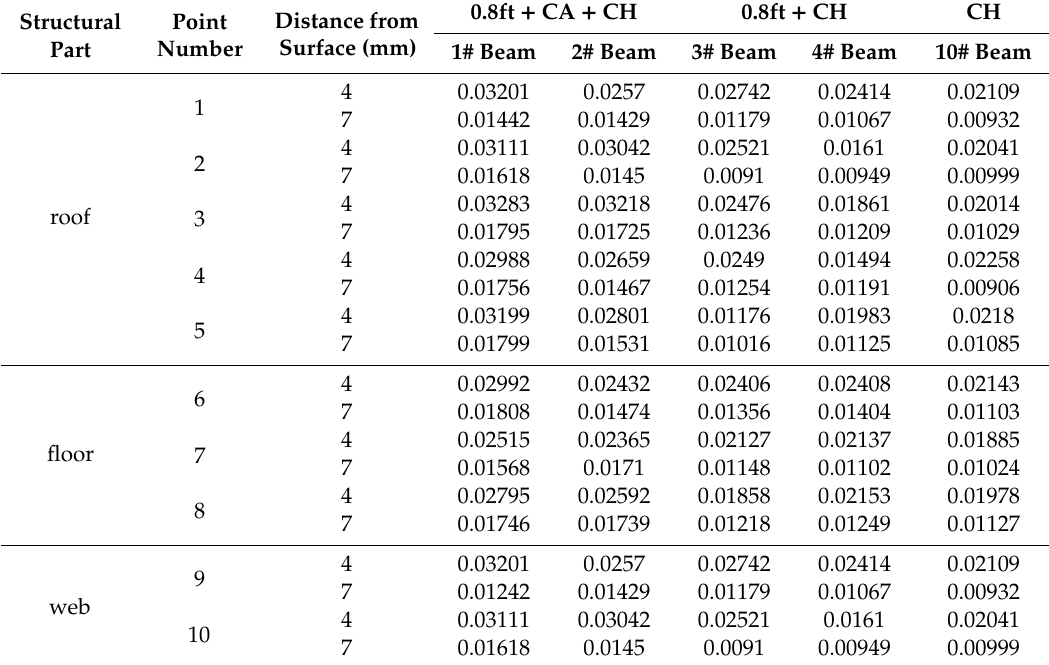
Table 6. Measurement results of chloride ion inside the box beam under di ff erent erosion e ff ects (%).